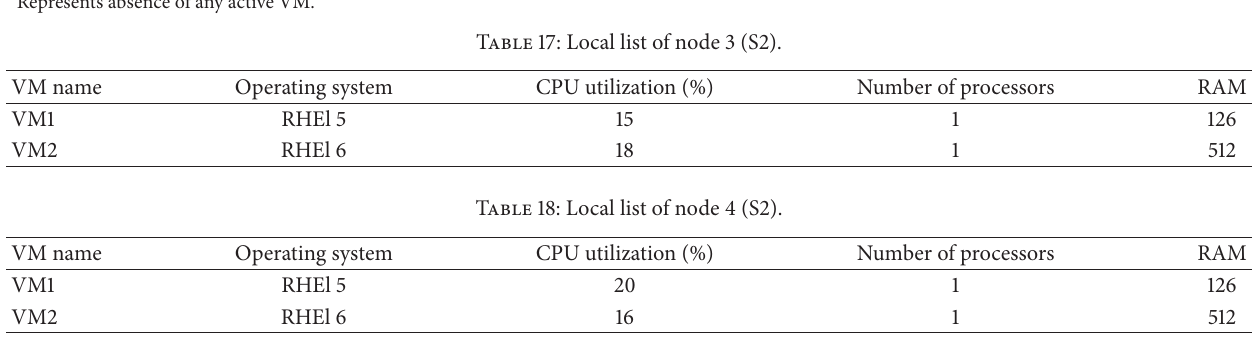
Table 19: Predict table (S2).